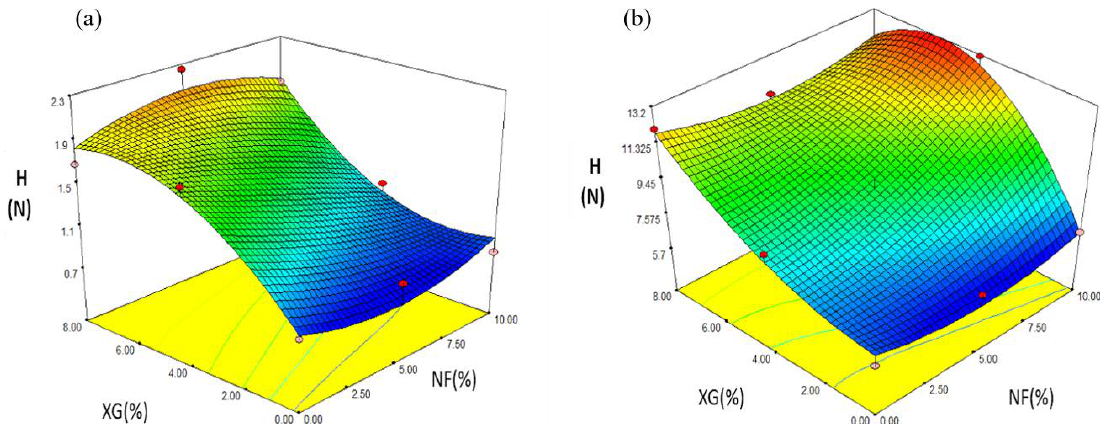
Figure 7. Effect of fiber (NF) and rubber (XG) interaction on the H (N) of snacks made with: ( a ) native starch and ( b ) starch modified by